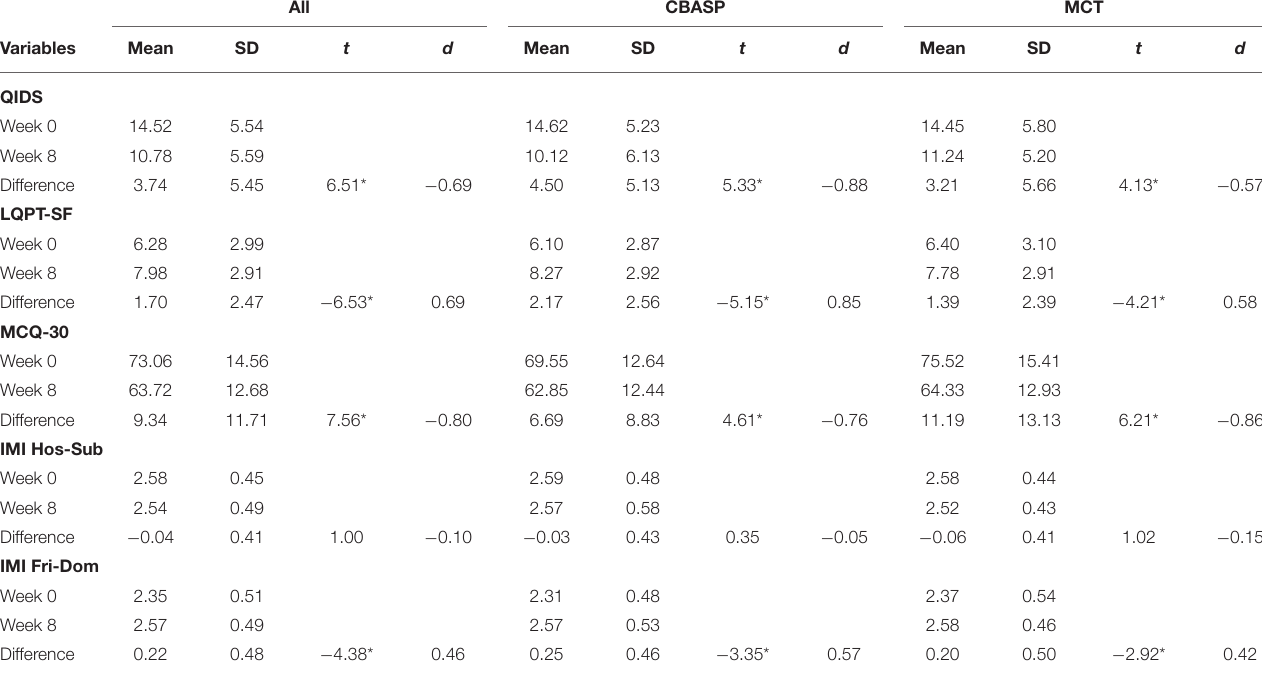
TABLE 2 | Outcome variables.